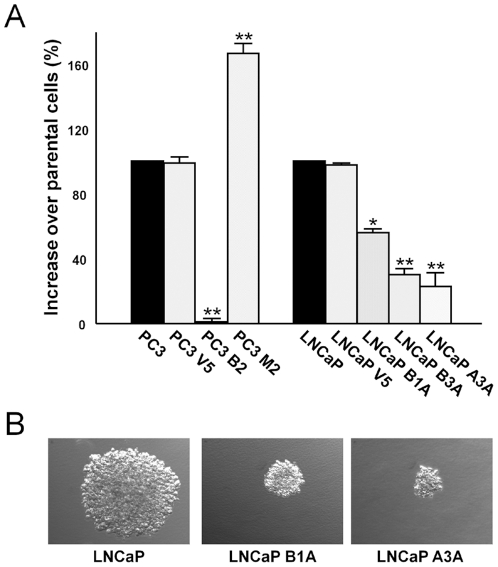
Mitostatin affects anchorage-independent growth of prostate cancer cells.
A: Data from triplicate cultures of parental PC3 and LNCaP, and clones PC3 V5, PC3 B2, PC3 M2, LNCaP V5, LNCaP B1A, LNCaP B3A, and LNCaP A3A plated in soft-agar generating colonies larger than 0.2 mm in diameter. Clones over-expressing Mitostatin showed a decreased ability to form colonies, while the Mitostatin down-regulated clone, PC3 M2, showed a higher number of colonies compared to parental cells. Colonies were counted after 21 days. * P<0.05; ** P<0.01 B: Representative colonies of LNCaP parental cells (left), LNCaP B1A (middle), and LNCaP A3A (right) are shown after 21 days (magnification ×200).